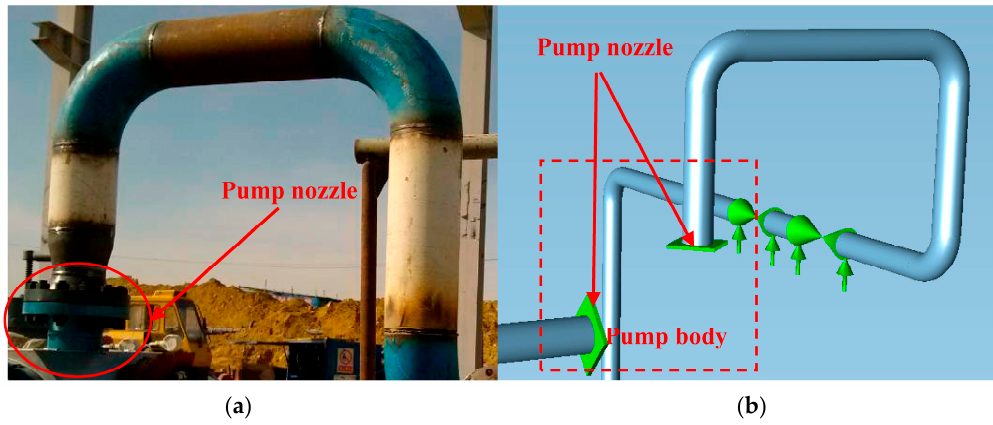
Figure 14. Pump nozzle: ( a ) physical map and ( b ) numerical simulation model in CAESAR II software. (2) Valve and flange